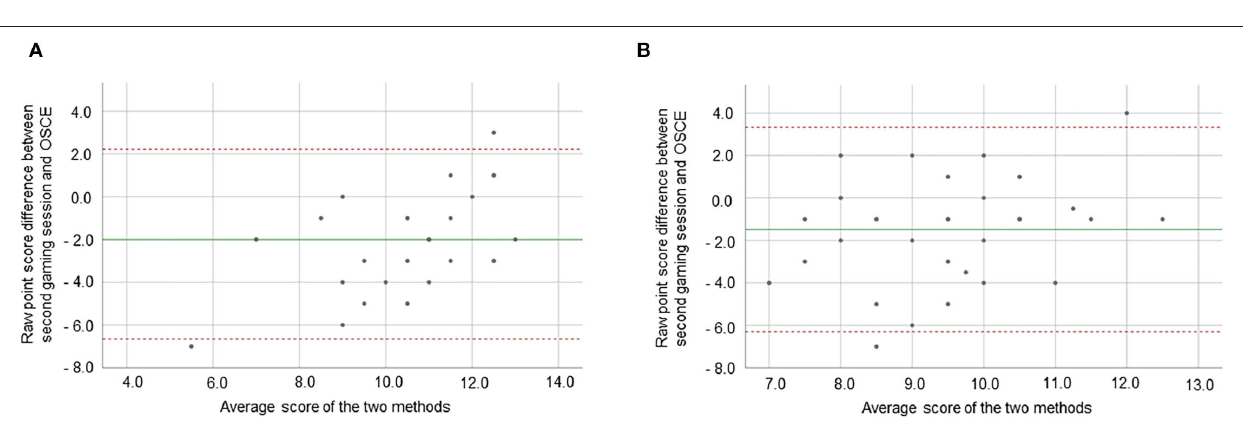
FIGURE 3 | Agreement between total scores in game logfiles and OSCE checklists for the two cases. (A,B) Bland Altman Plots for the EC and CAP case,